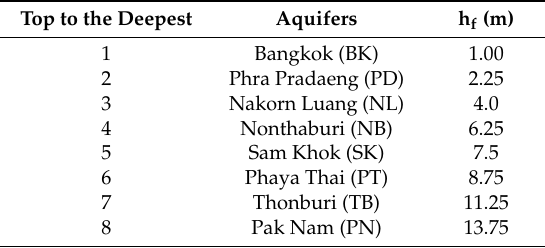
Table 2. Initial hydraulic conductivity, K, for model. Zone